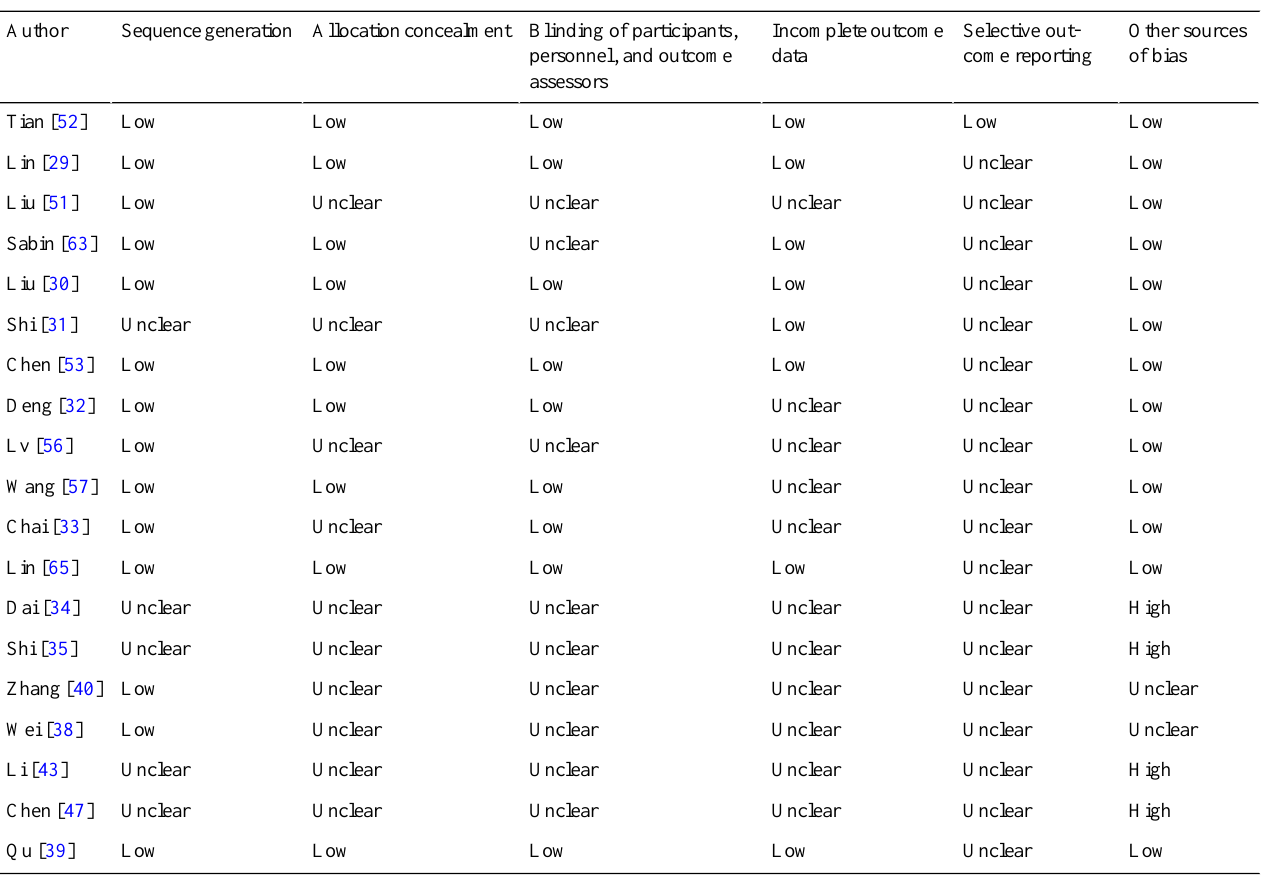
Table 3. Risk of bias assessment for randomized controlled